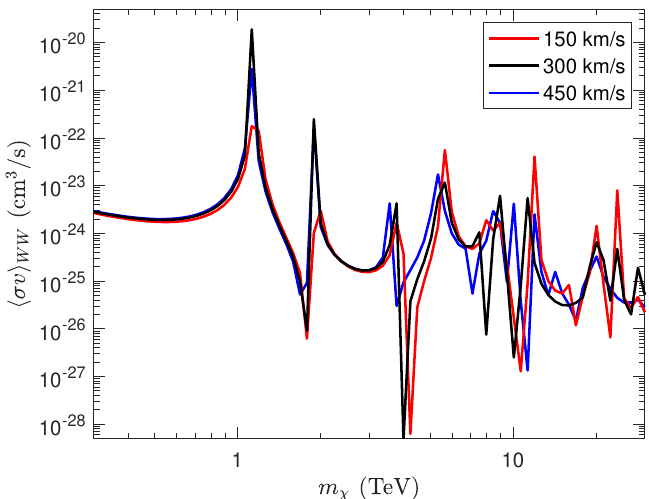
Figure 5. Annihilation cross-section of the complex quartet (C4) DM pair into W + W − diboson channel for three different velocities at the thermal mass: one-standard deviation below the average v − σ v = 150 km/s (in red), the mean velocity v = 300 km/s (black), and one-standard deviation above the average v + σ v = 450 km/s